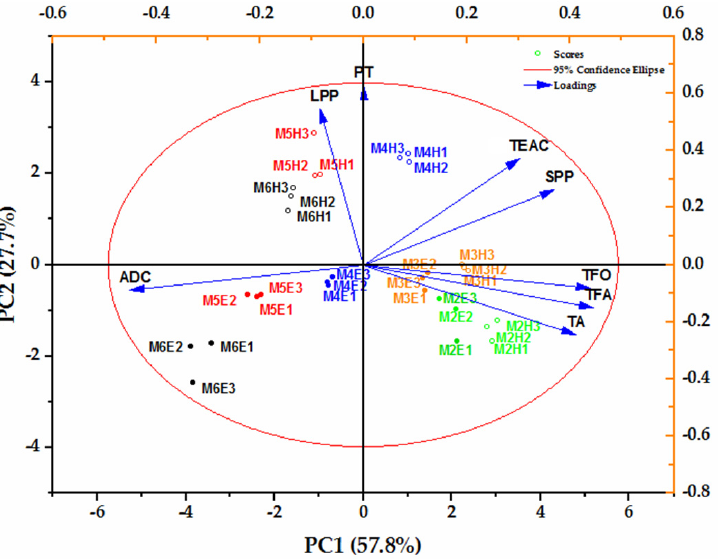
Figure 4. Principal component analysis of acetaldehyde, TEAC and key phenolic compounds data at 30 and 75 days of wine aging. Abbreviations: MiE1, MiE2 and MiE3 (i= 2, 3, 4, 5, 6), three bottles of wine with different initial acetaldehyde (2–6) at 30 days of aging; MiH1, MiH2 and MiH3 (i= 2, 3, 4, 5, 6), three bottles of wine with different initial acetaldehyde (2–6) at 75 days of aging; TEAC, antioxidant activities expressed as Trolox equivalents per liter of wine (mM TEAC/L); ADC, acetaldehyde consumption; TA, total anthocyanins; TFA, total flavanols; TFO, total flavonols; SPP, short polymeric pigments; LPP, large polymeric pigments; PT, polymeric